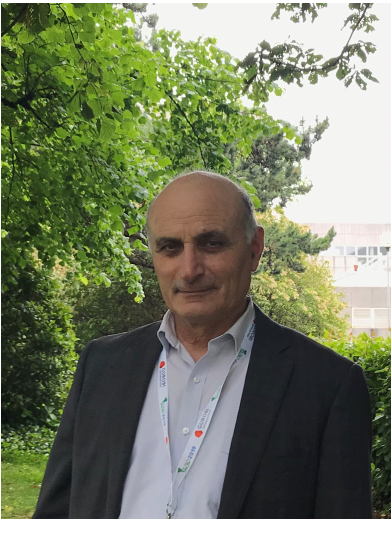
Figure 1. Professor Adil